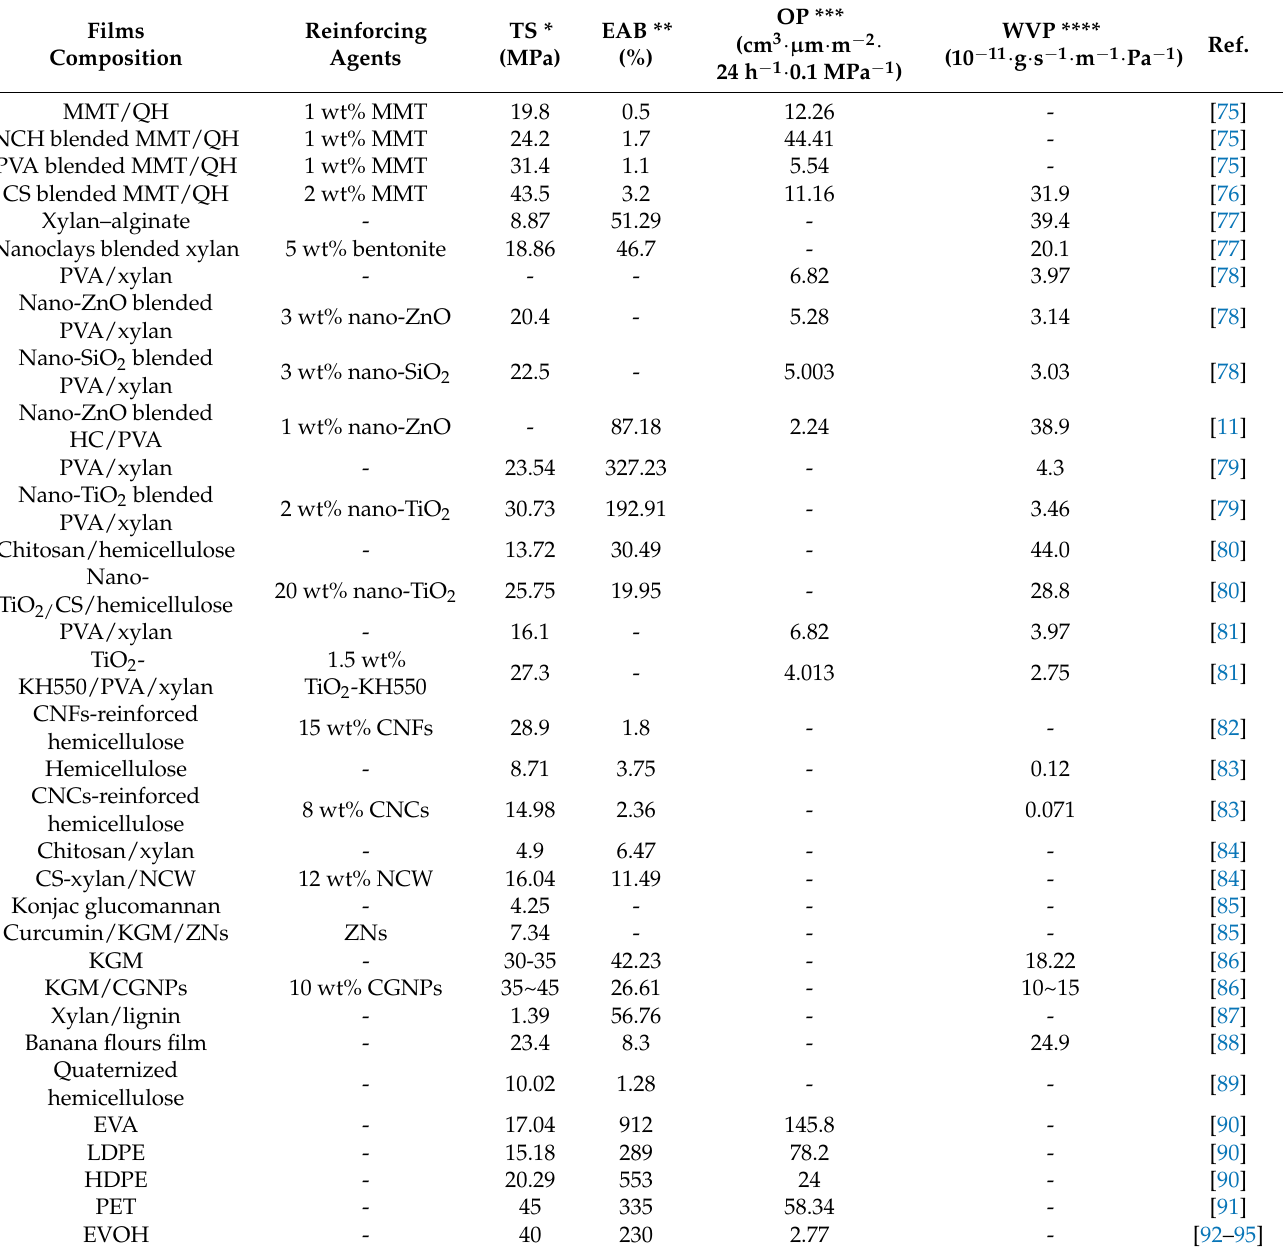
Table 3. Mechanical properties and barrier properties of different